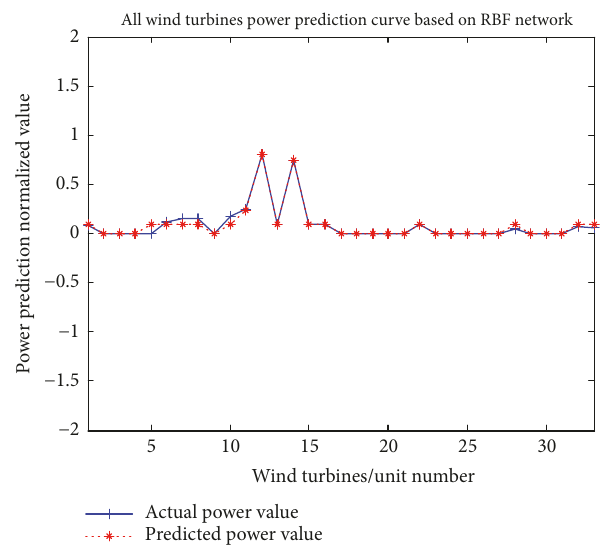
Figure 8: All wind turbines power forecast curve.